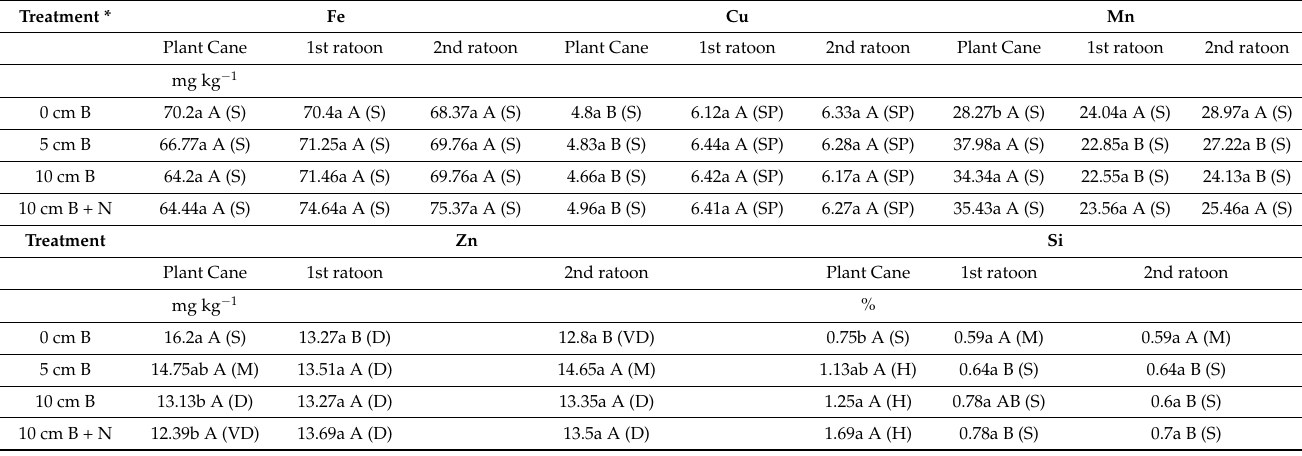
Table 5. Leaf micronutrient concentrations for plant cane and two ratoon